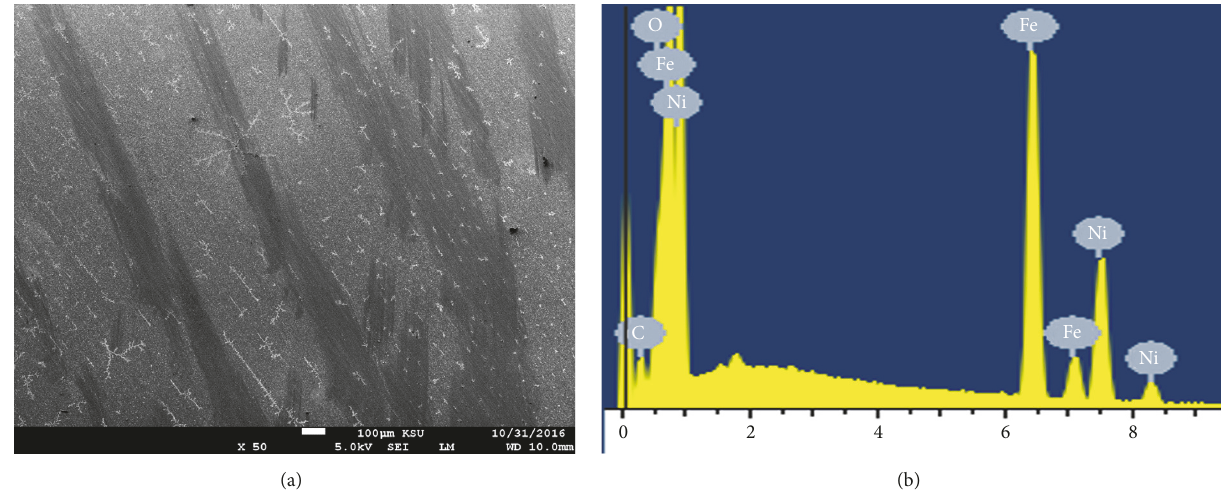
Figure 3: (a) SEM micrograph for the surface of the Fe-36% Ni alloy after its immersion in 1M HCl solutions for 96 h and (b) the corresponding EDS profile analysis shown in the SEM image.